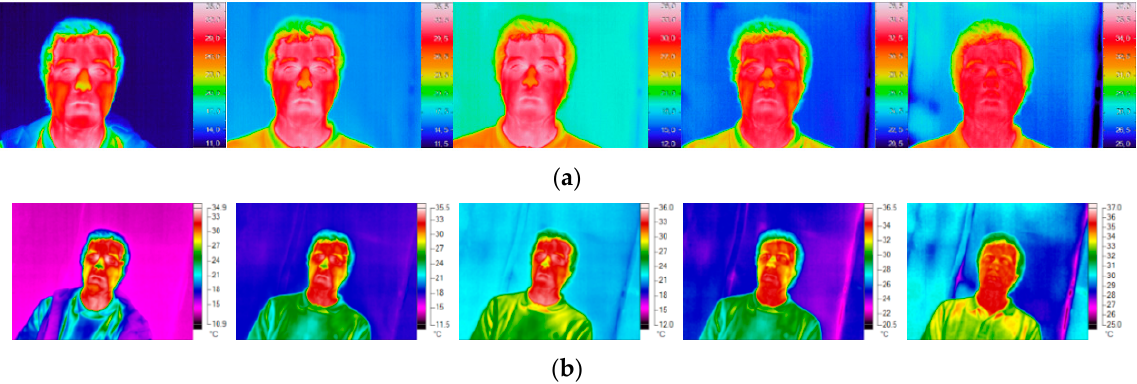
Figure 4. Thermal images for T SP values of 10 °C, 16 °C, 20 °C, 24 °C, and 30 °C with an HR SP of 60%: ( a ) IR camera 1; ( b ) IR camera 2.